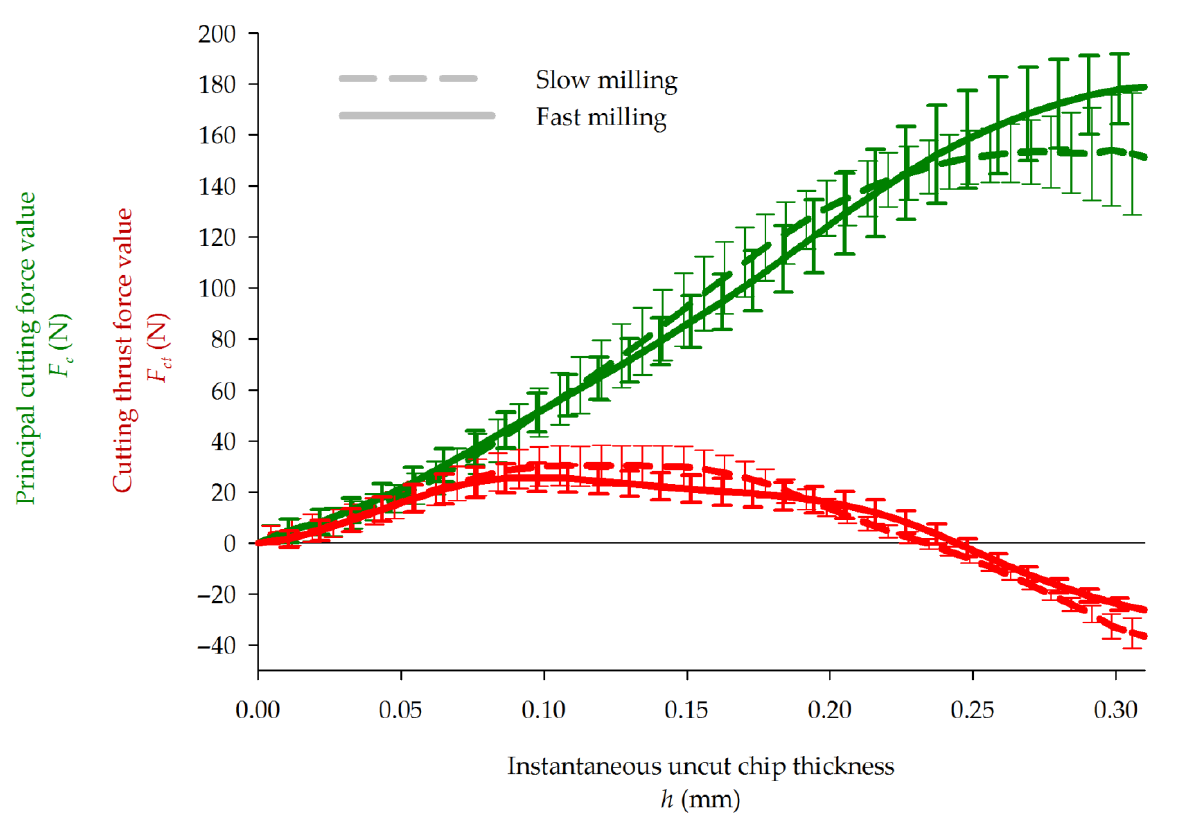
Figure 10. Principal (green) and thrust (red) cutting forces in function of IUCT.